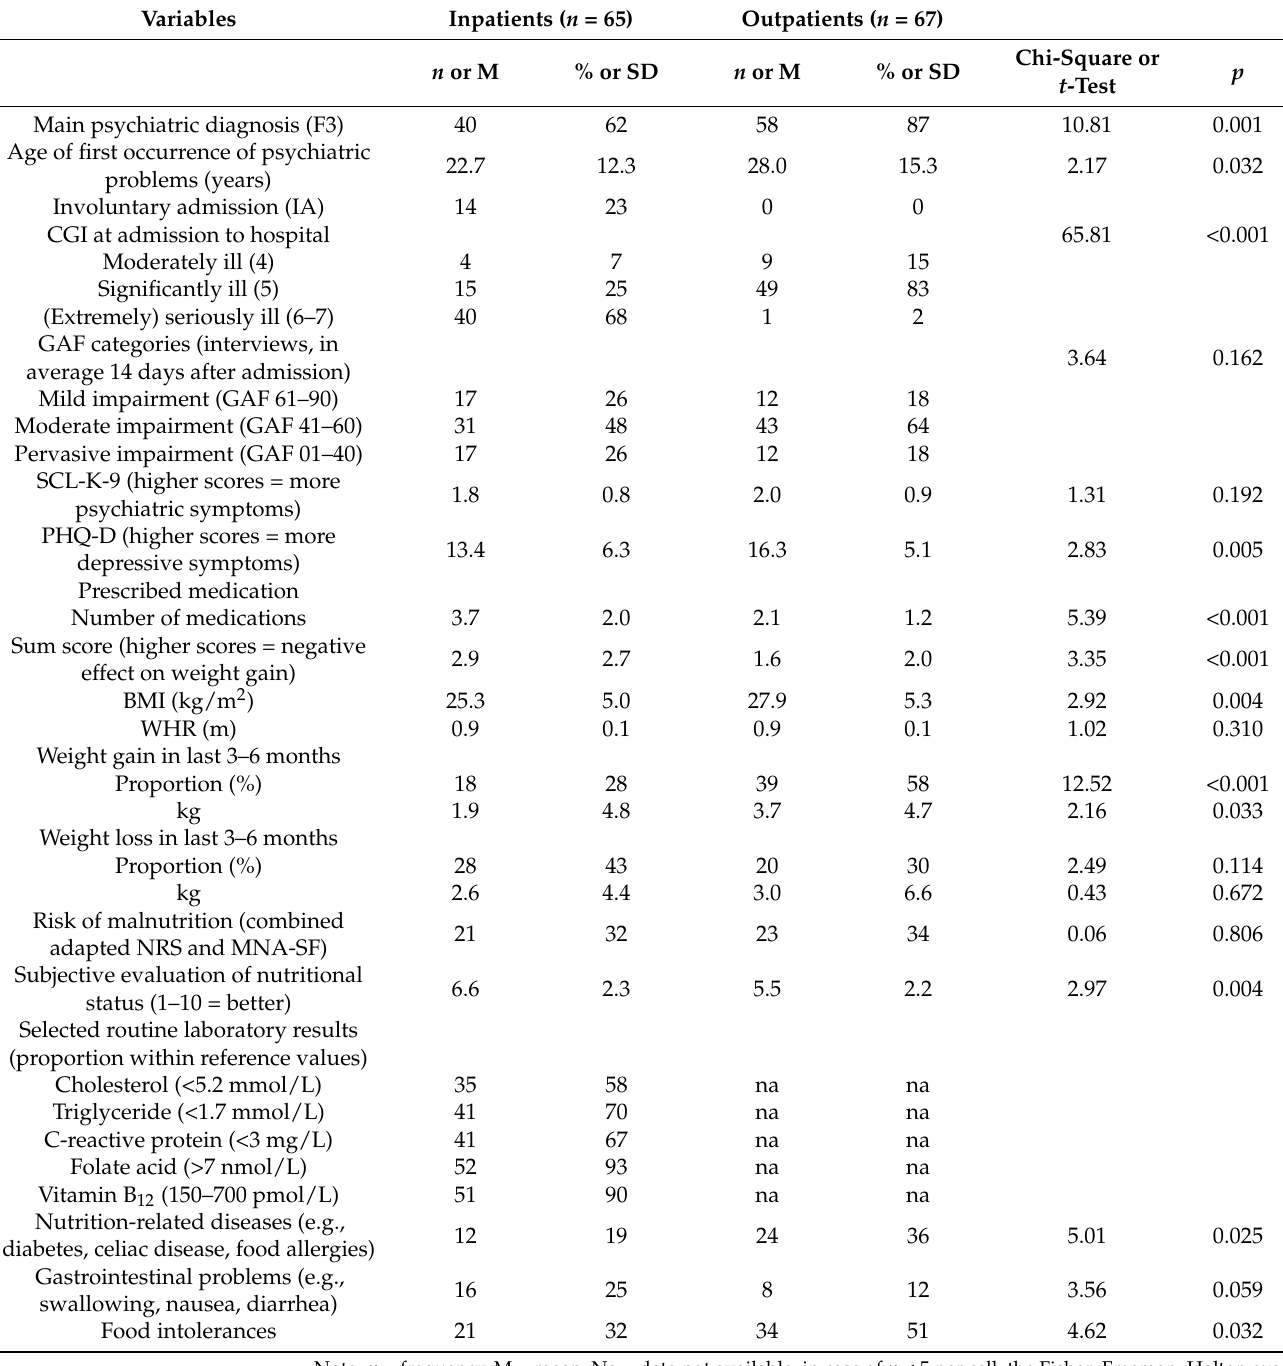
Table 2. Variables related to the participants’ mental condition and nutritional